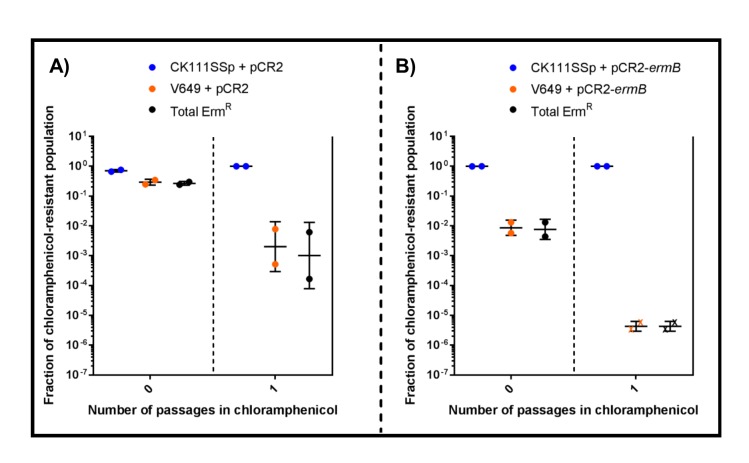
CRISPR targeting and two-strain competition can remove antibiotic resistances in vitro.CK111SSp(pCF10-101) carrying (A) pCR2 or (B) pCR2-ermB was conjugated into V649 and the reaction was passaged in chloramphenicol overnight. ‘X’ values indicate those that fell below the threshold of detection. The geometric mean and geometric standard deviation are shown for two independent biological replicates.